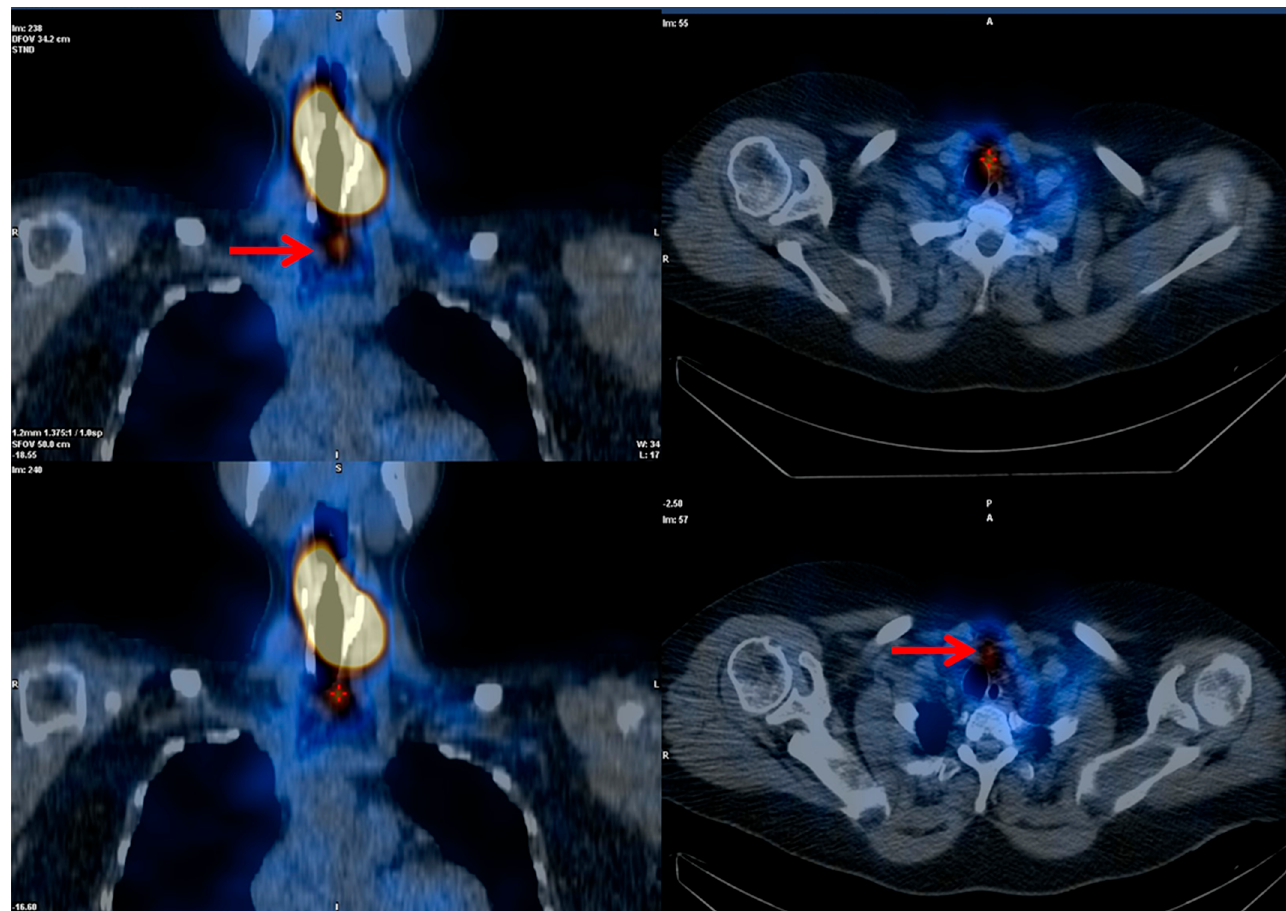
Figure 1. ( A , B ) 40 years old female, with multifocal papillary microcarcinoma (left lobe 7 mm and 2 foci of 1 mm in the right lobe (pT1a(m)N0). TSH 67.83 mIU/L, Tg 11.83 µ g/L (<2 µ g/L), and TgA 2.2 kIU/L (<4.5 kIU/L). Diagnostic WBS and SPECT/CT ( A , B ) performed after application of 74 MBq of [ 131 I] show two focuses of [ 131 I] uptake—larger in the right upper part of the region VI and small focus lower in the region VI, right paratracheal. The patient was treated with 1665 MBq (45 mCi) of [ 131 I]. Post ‐ treatment [ 131 I] WBS ( C ) shows an accumulation of the [ 131 I] in the same two focuses.